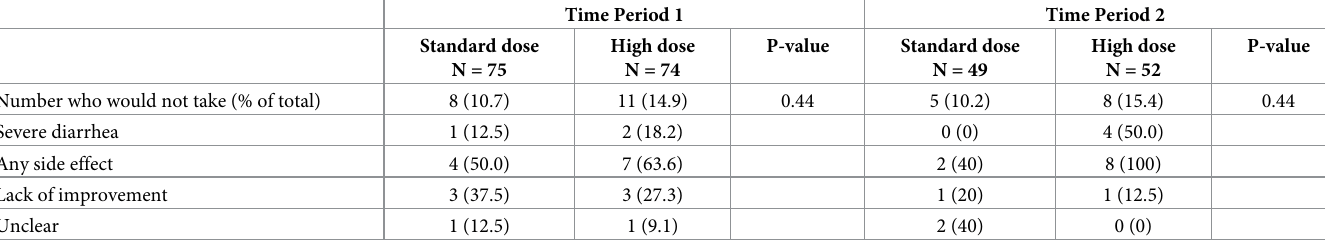
Table 6. Reasons for not taking antibiotic again (cid:3)